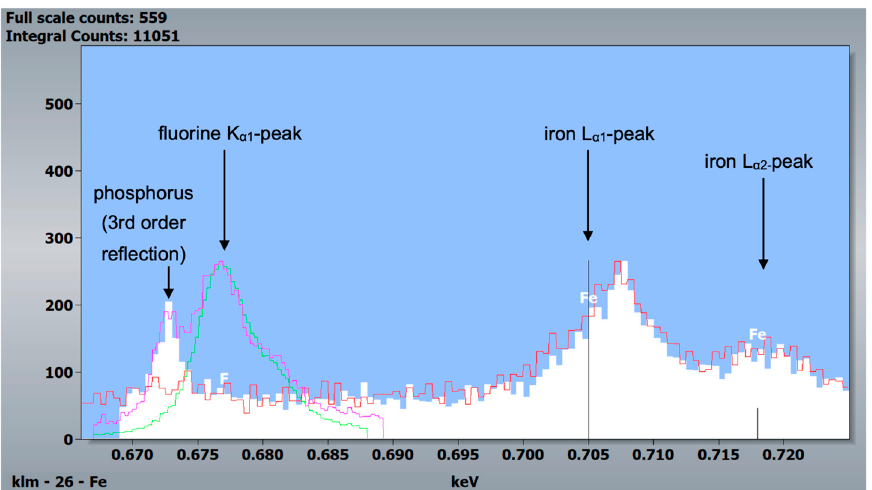
Figure 9. WDX measurements of a mouse specimen (post-eruptive enamel) and the two standards,